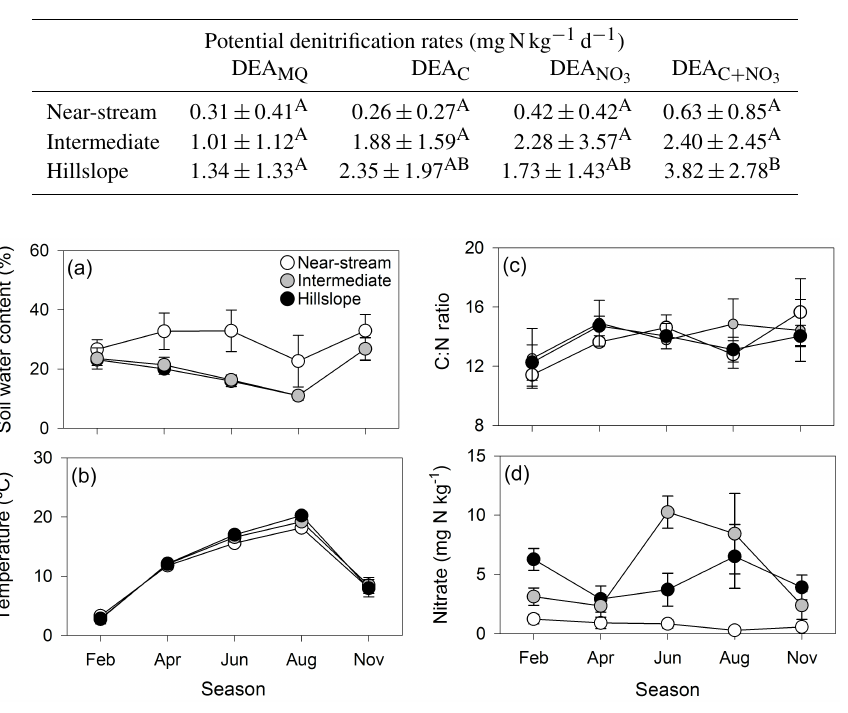
Table 3. Mean values ( ± SD) of potential denitrification rates (in mgNkg − 1 d − 1 ) after anoxia (DEA MQ ), carbon addition (DEA C ), nitrogen ) treatments for the three riparian zones during the study period. For each ), and carbon and nitrogen addition (DEA C + NO addition (DEA NO 3 3 zone, different letters indicate statistical significant differences between treatments (post hoc Tukey HSD test, n = 15, p < 0 . 01).